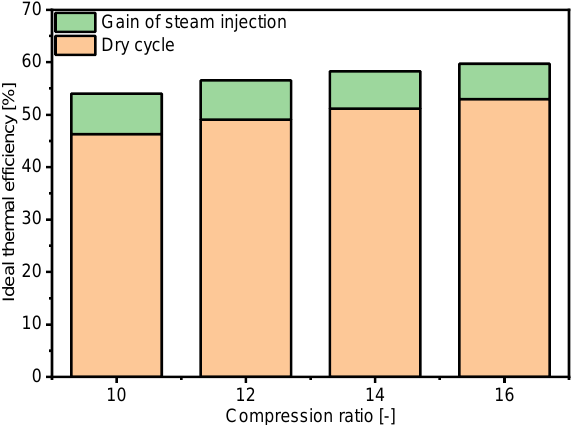
Figure 10. Comparison of thermal efficiencies at different compression ratios.